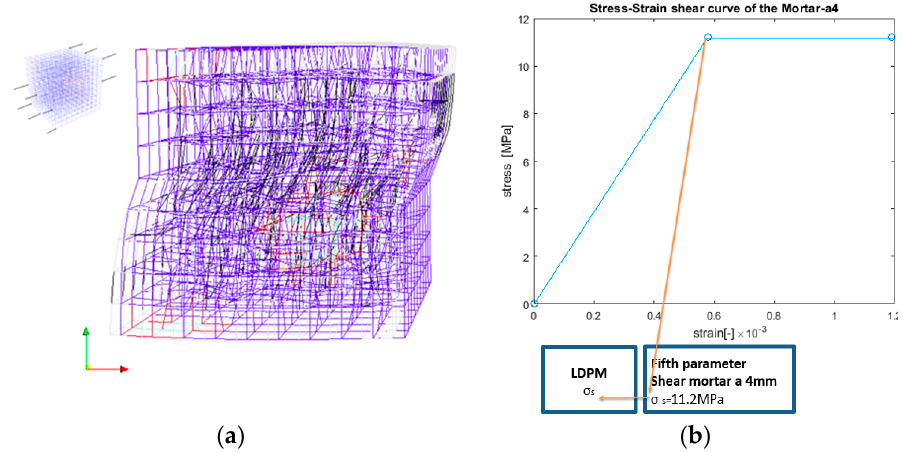
Figure 13. ( a ) Shear damage mode (damaged elements in blue; white box represents the non-deformed shape); and ( b ) mortar-a4 shear stress–shear strain